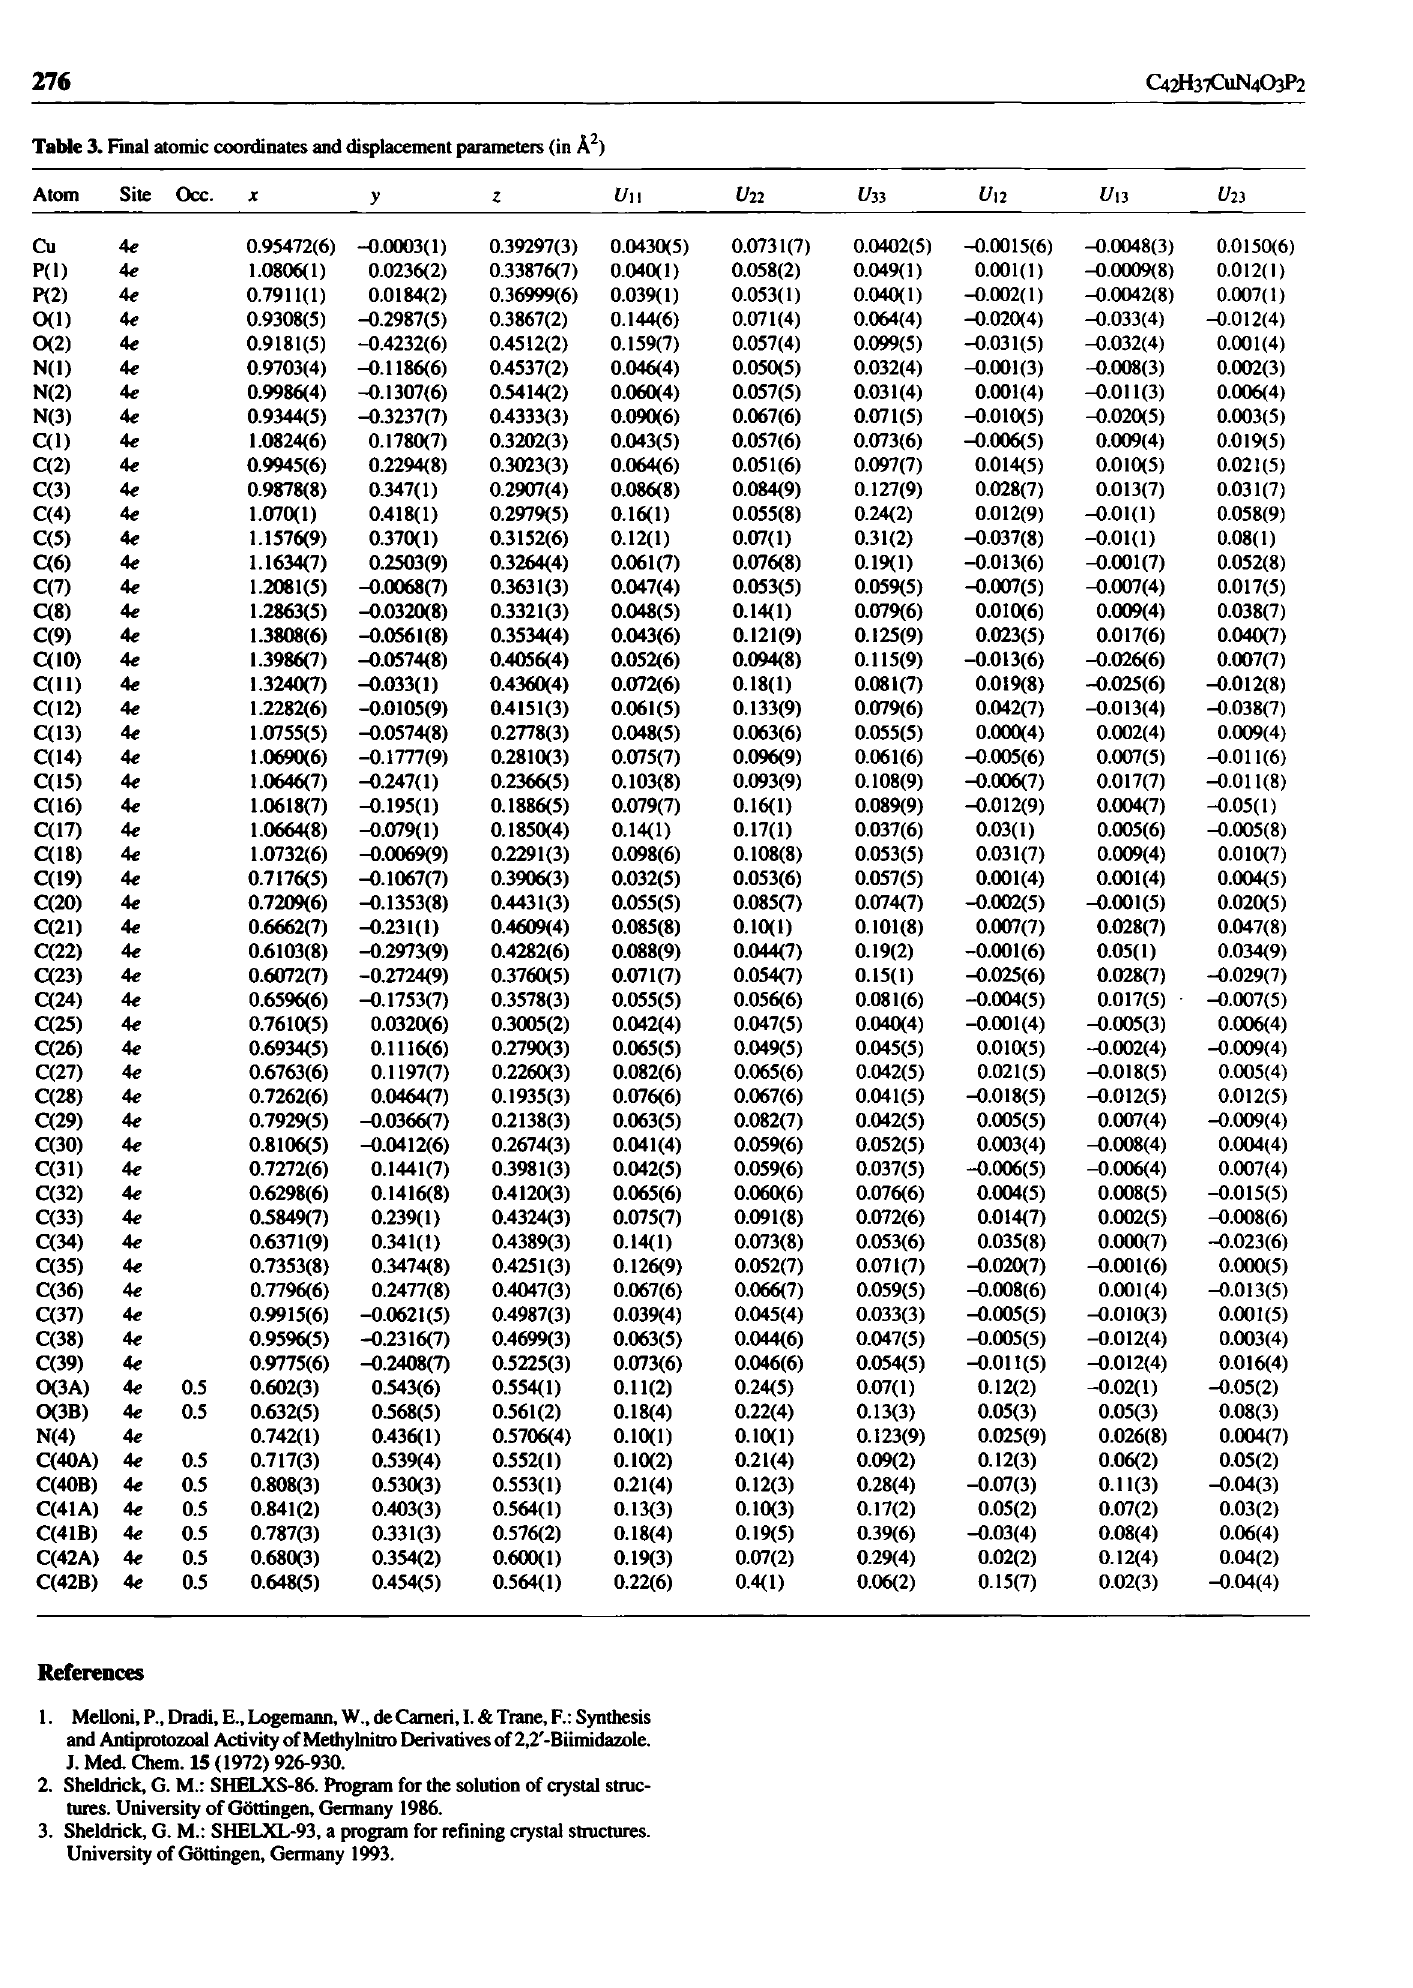
Table 3. Final atomic coordinates and displacement parameters (in Â 2 ) Atom Site